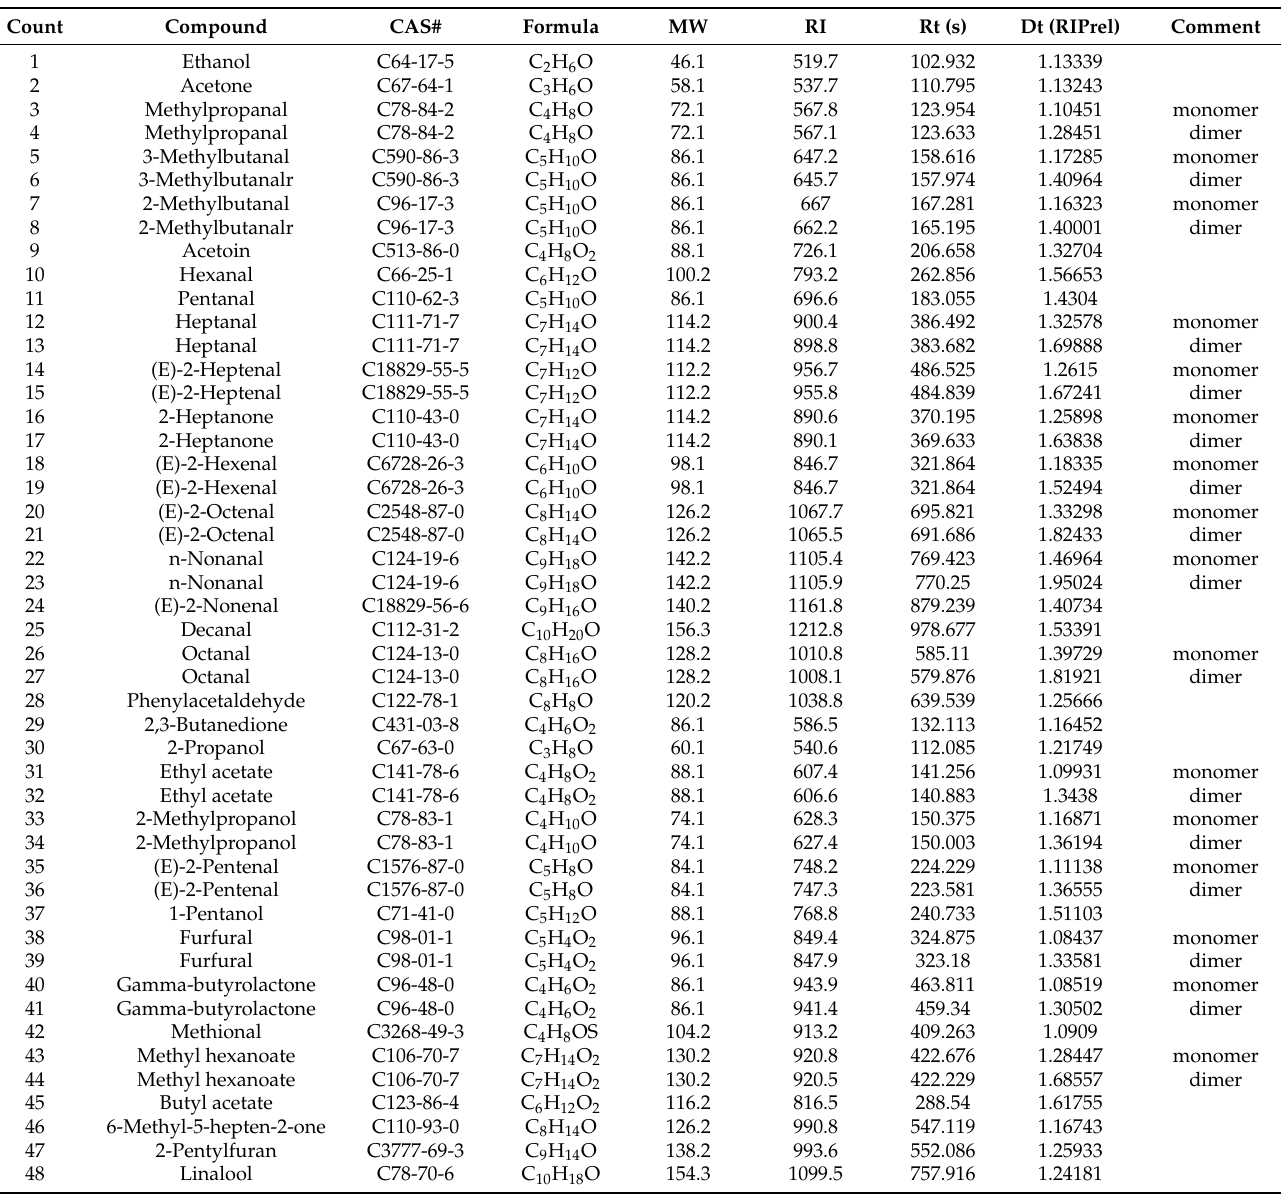
Table 1. Qualitative results of different